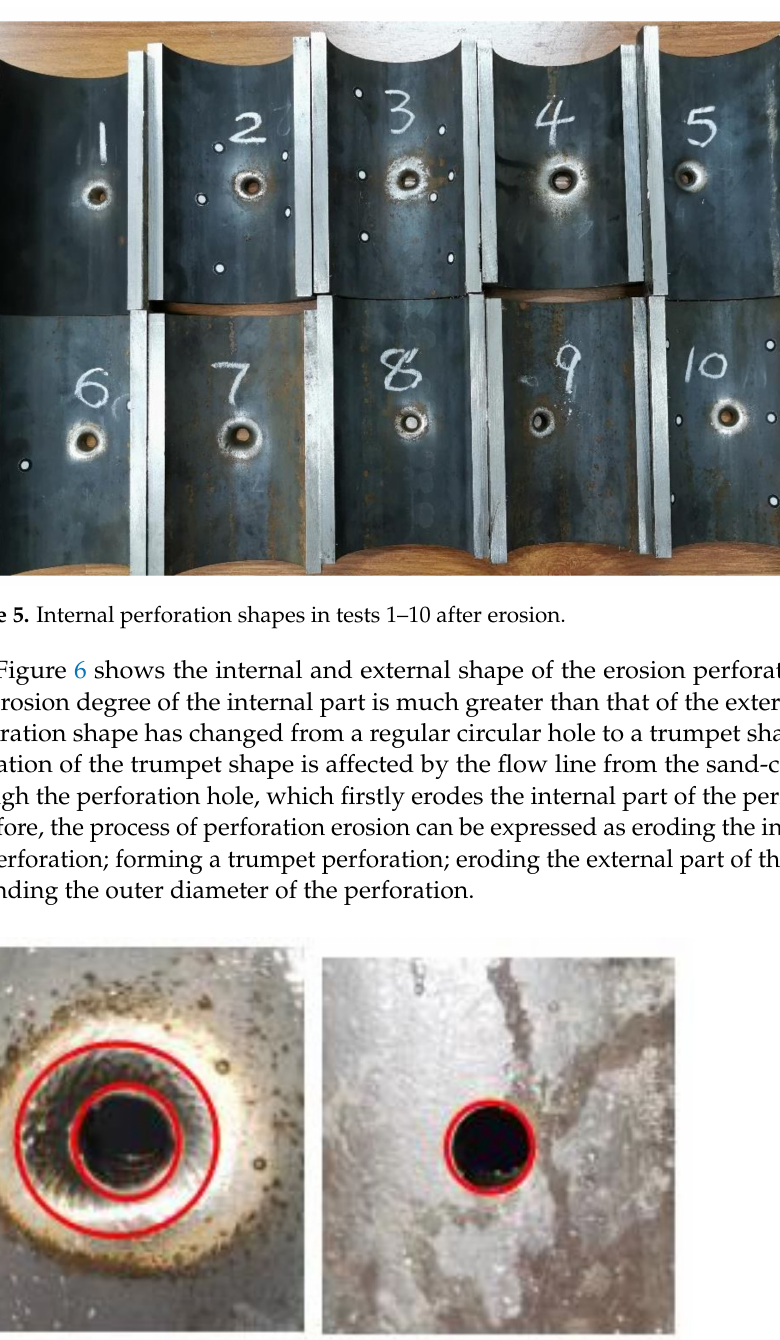
Figure 6. Perforation shape after erosion ( left , internal part; right , external